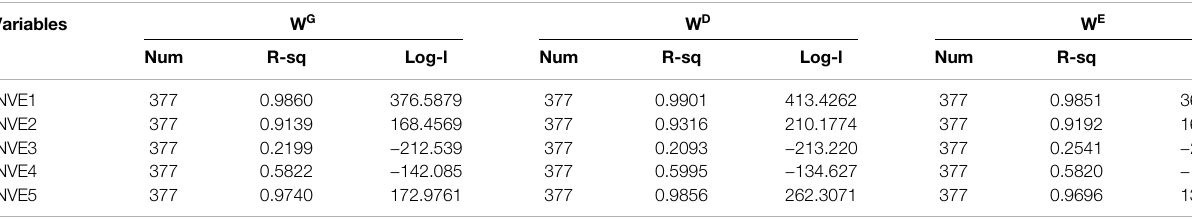
TABLE 4 | Statistics of the random effects SDM.